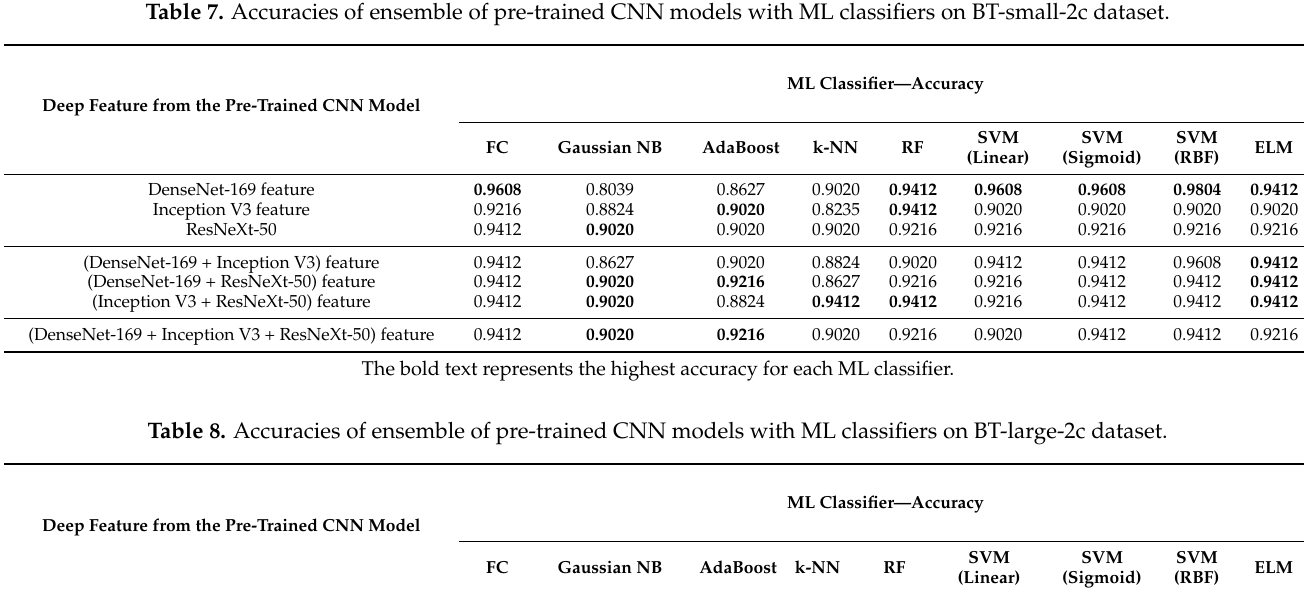
Table 7. Accuracies of ensemble of pre-trained CNN models with ML classifiers on BT-small-2c dataset.